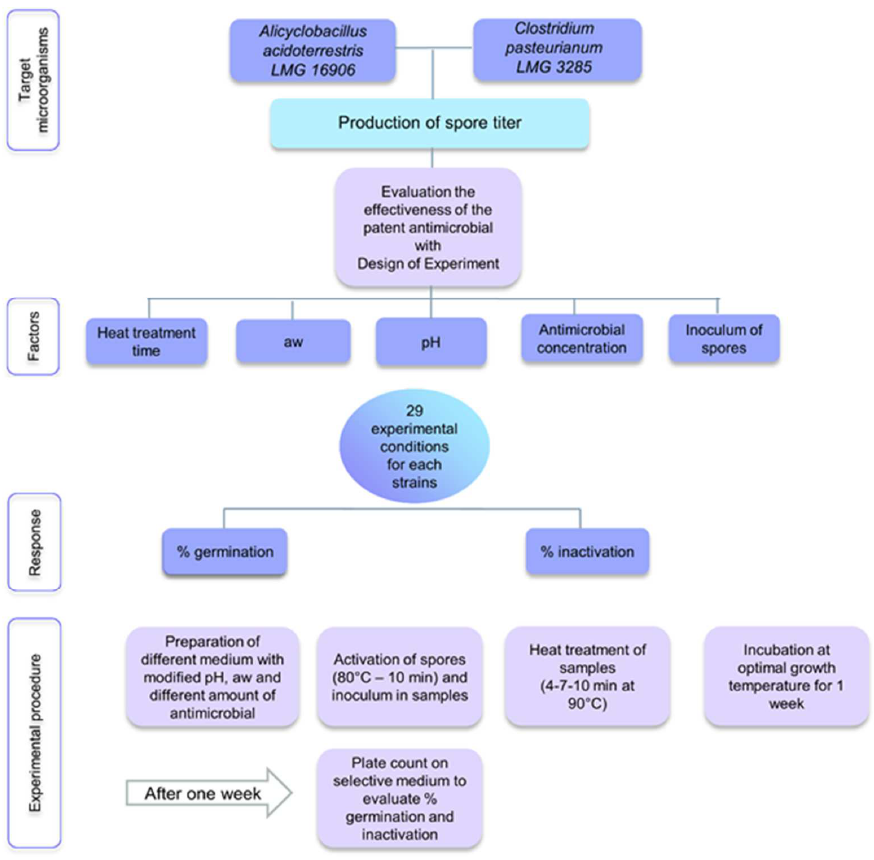
Figure 1. Experimental procedure of the study.